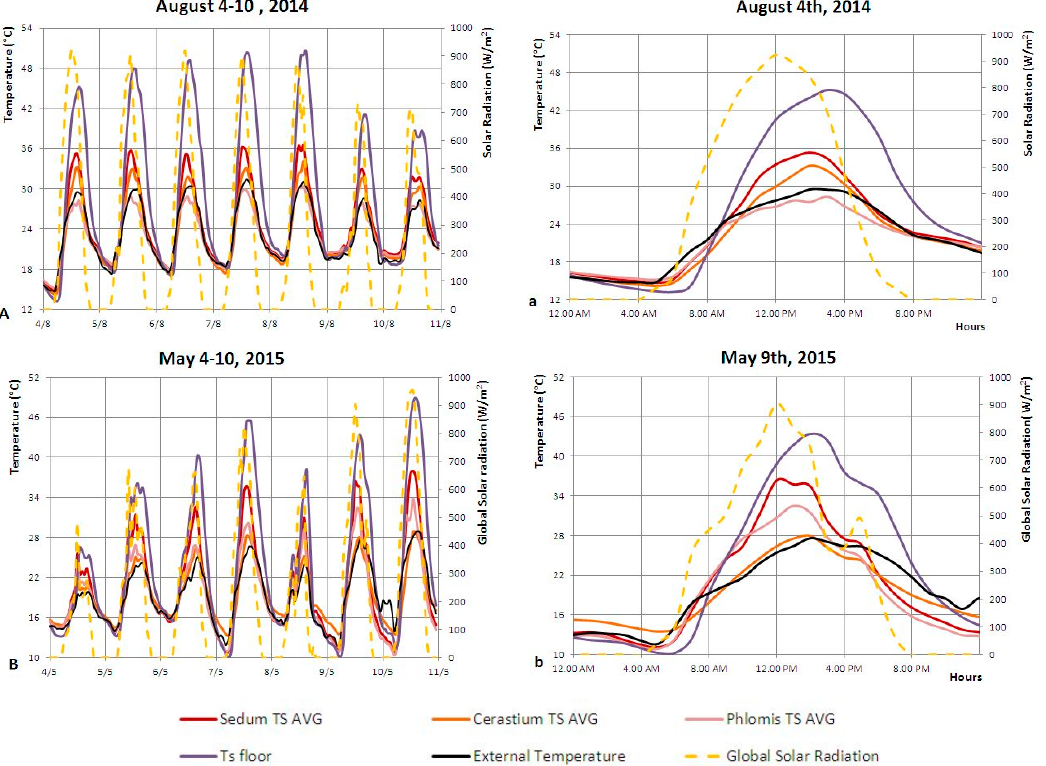
Figure 5. Ts analysis as a function of the global solar radiation and the external temperature (T e ): ( A , a ) summer 2014; ( B , b ) spring 2015. Upper case letters refer to the reference week, while lower case letters refer to the reference day.